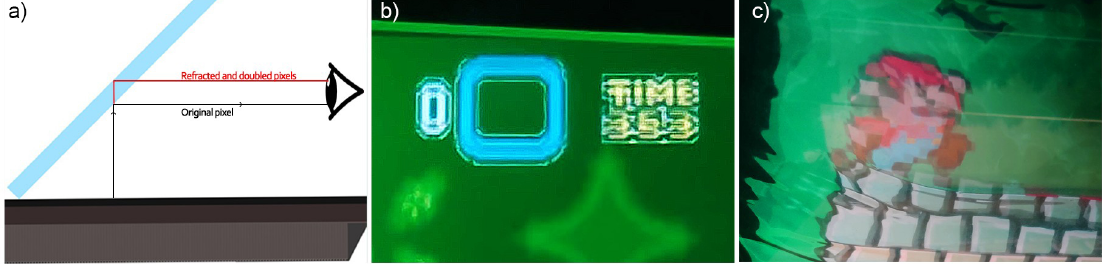
Figure 4. ( a ) Double reflections ray diagram. ( b ) Double reflection effect on a 2-mm PE sheet. ( c ) Wobbly effect on a 0.25-mm acetate